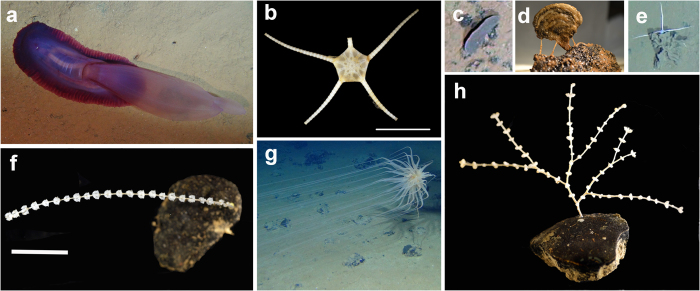
Dominant megafauna observed in the eastern CCZ.(a) Psychropotes cf. semperiana; (b) Ophiomusium cf. glabrum; (c) Xenophyophore plate-like morphotype 1: Psammina sp. in situ on seafloor; (d) Xenophyophore plate-like morphotype 1: Psammina sp. in situ close up; (e) Xenophyophore plate-like morphotype 8/9; (f) Calyptrophora persephone; (g) Relicanthus sp.; (h) Abyssoprimnoa gemina. Image attribution: (a,c,e,g) - DJ Amon & CR Smith, University of Hawai’i; (d) – AJ Gooday and A Goineau, National Oceanography Centre, Southampton; (b,f,h) – AG Glover, TD Dahlgren & H Wiklund, Natural History Museum, London & Uni Research.